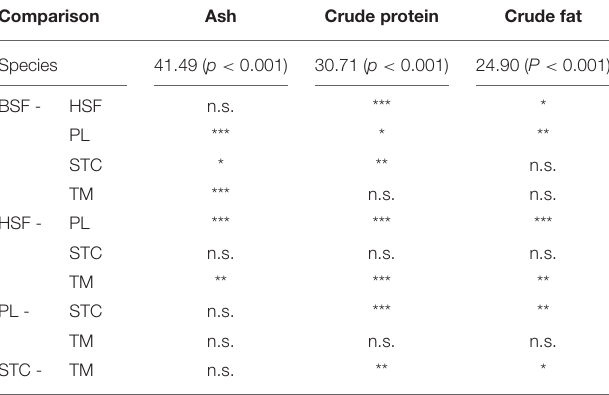
TABLE 3 | Statistical output of a series of non-parametric tests: firstly, Kruskal-Wallis output, in the form χ 2 ( p -value), assessing whether species differ in their content of ash, crude protein, and crude fat, and below the post-hoc significance output determining whether individual species pairs differ in their levels of these proximate